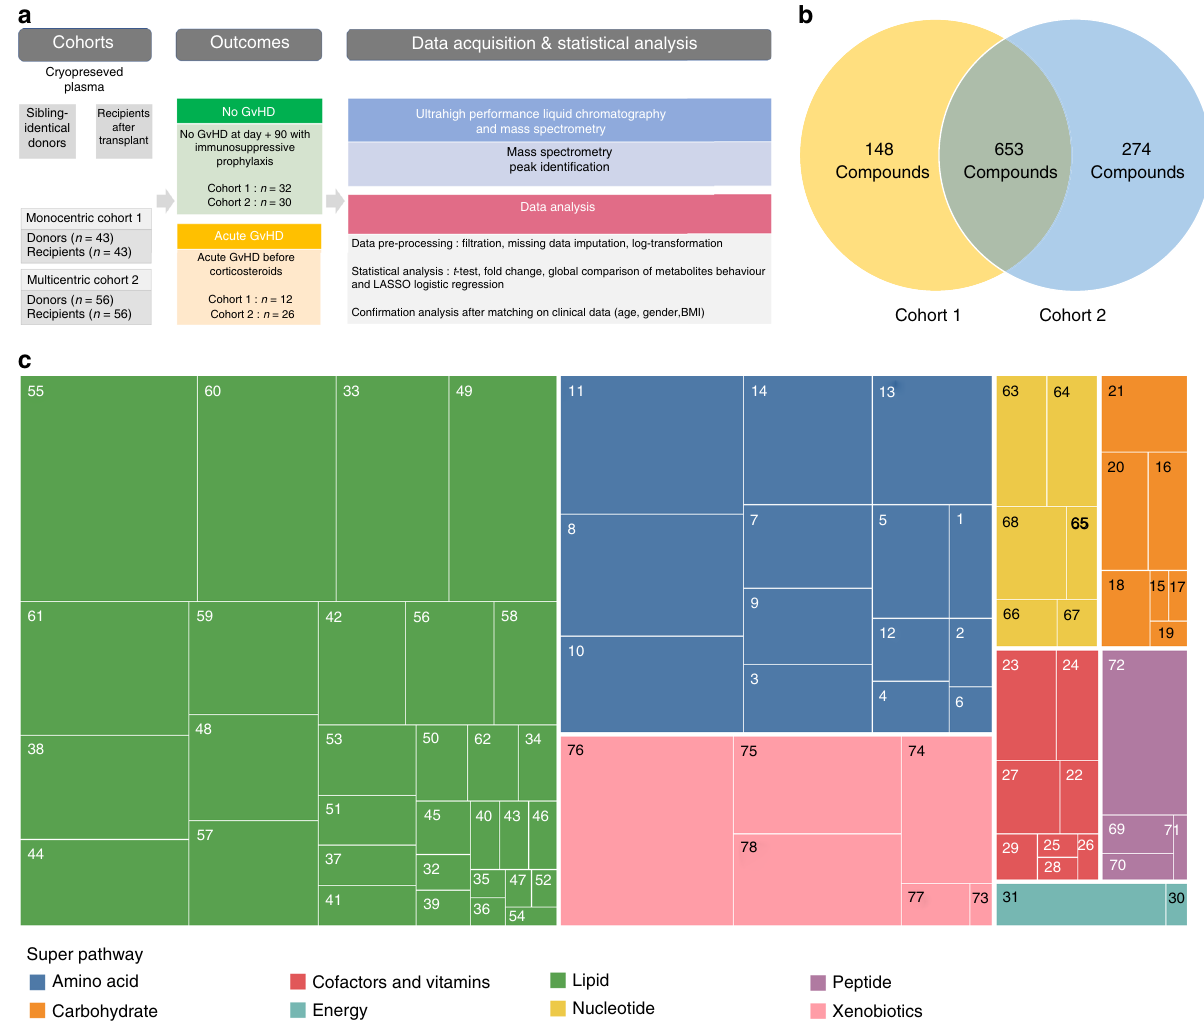
Fig. 1 Study design and general overview of detected metabolites. a Metabolomic pro fi le was studied in two cohorts of patients, a single center cohort from Saint Louis hospital, Paris (cohort 1), and a multicentric French cohort (cohort 2). Plasma samples were collected in sibling donors before stem cell collection and in recipients after transplantation, at day 90 for those who did not developed GvHD or before corticosteroid treatment at disease onset for those who developed GvHD. Samples were frozen and then analyzed by ultrahigh-performance liquid chromatography-tandem mass spectrometry (UPLC- MS/MS) for circulating metabolites identi fi cation and quanti fi cation. *One donor did not give his consent for further analysis. b In all, 801 and 923 metabolites were identi fi ed in cohorts 1 and 2, respectively, with 653 metabolites shared by both cohorts. c Treemap showing the distribution of metabolites among super pathway (in color) and their related sub-pathways (square) for the 653 metabolites used for statistical analysis. Each number corresponds to one of the sub-pathway listed in Source Data fi